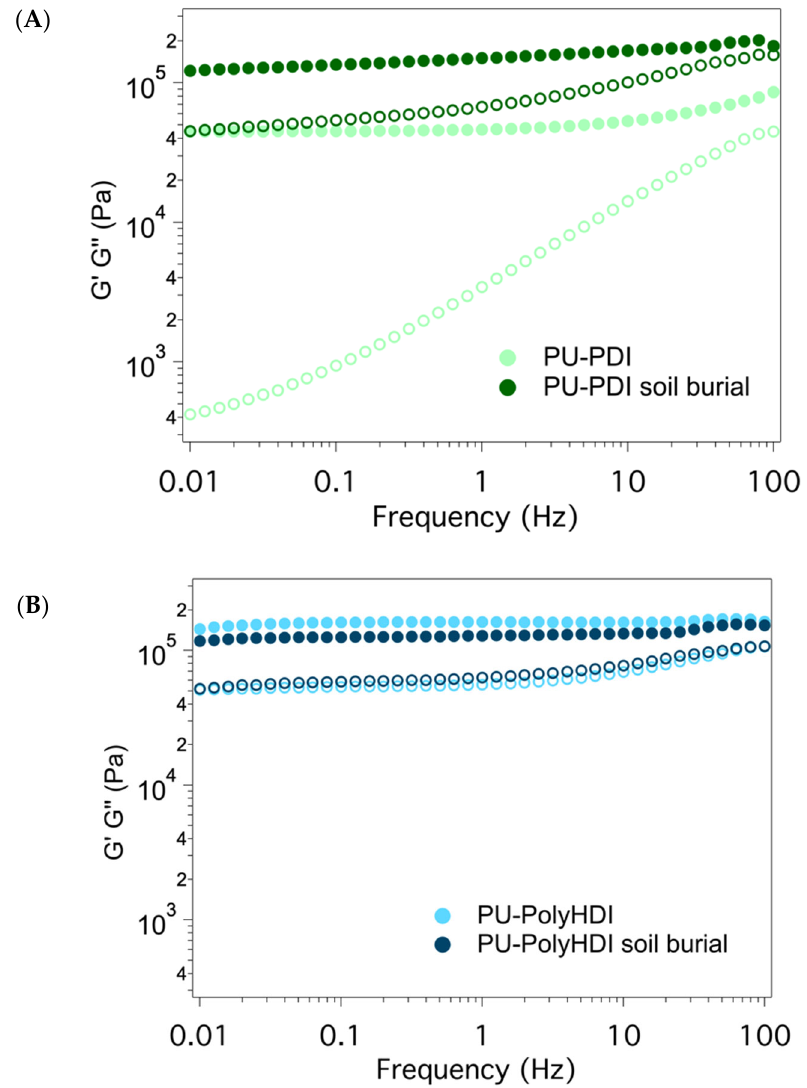
Figure 10. Frequency sweep curves of PUs samples before and after the soil burial test. ( A ) PU ‐ PDI, and ( B ) PU ‐ PolyHDI. Solid and empty circular markers indicate G’ and G’’, respectively.